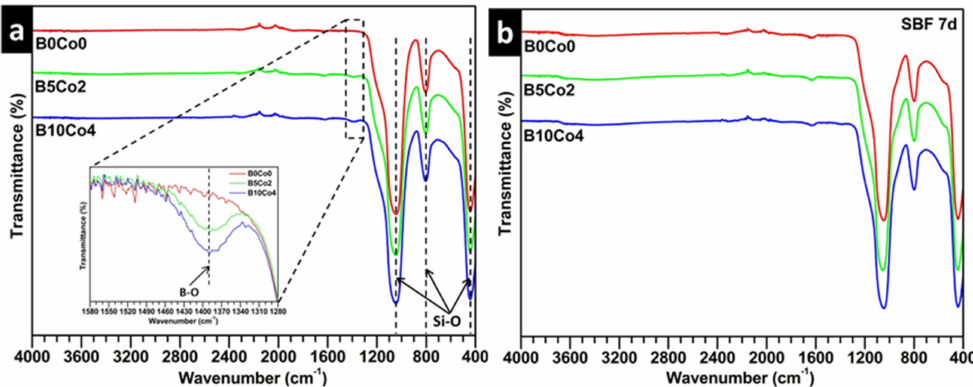
Figure 2. Fourier transform infrared (FTIR) spectra of the BCo.BGNs before ( a ) and after ( b ) immersion in SBF for 7 days. Main bands are indicated and discussed in the